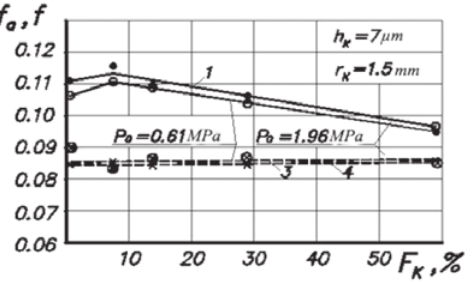
Fig. 4. Dependence of the adhesion component of the friction factor f а (curves 1, 2) and the friction factor f after the micro running-in (curve 3) on the relative area of micro grooves F к under constant contour pressure р с